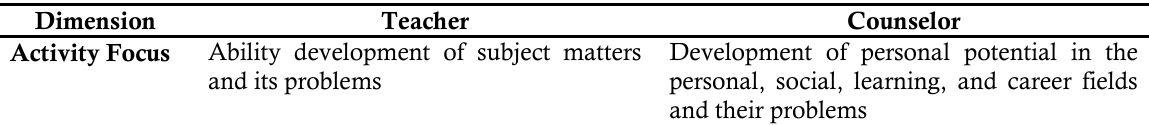
Table 1. The uniqueness and interrelation of teacher and counselor services